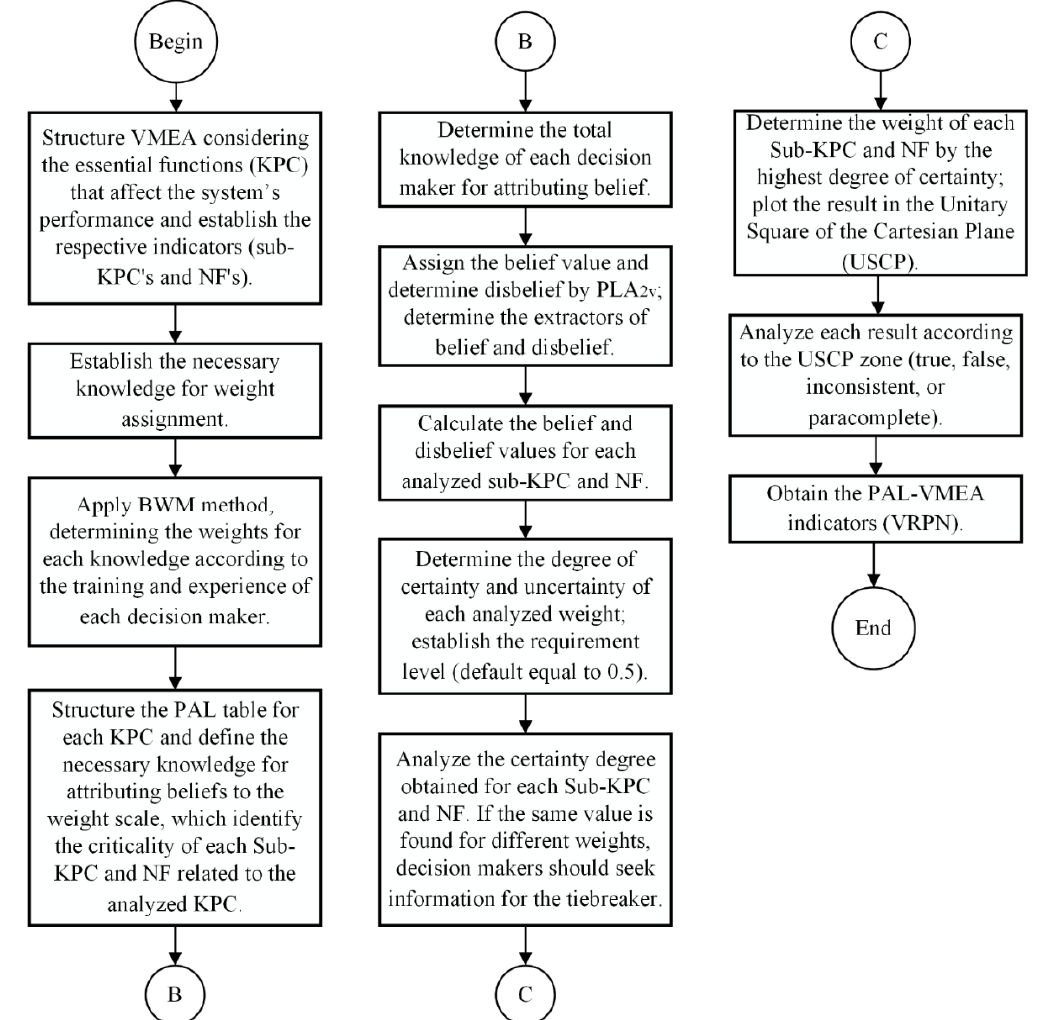
Figure 2. PAL-Variation and Mode Effect Analysis (VMEA) method framework.